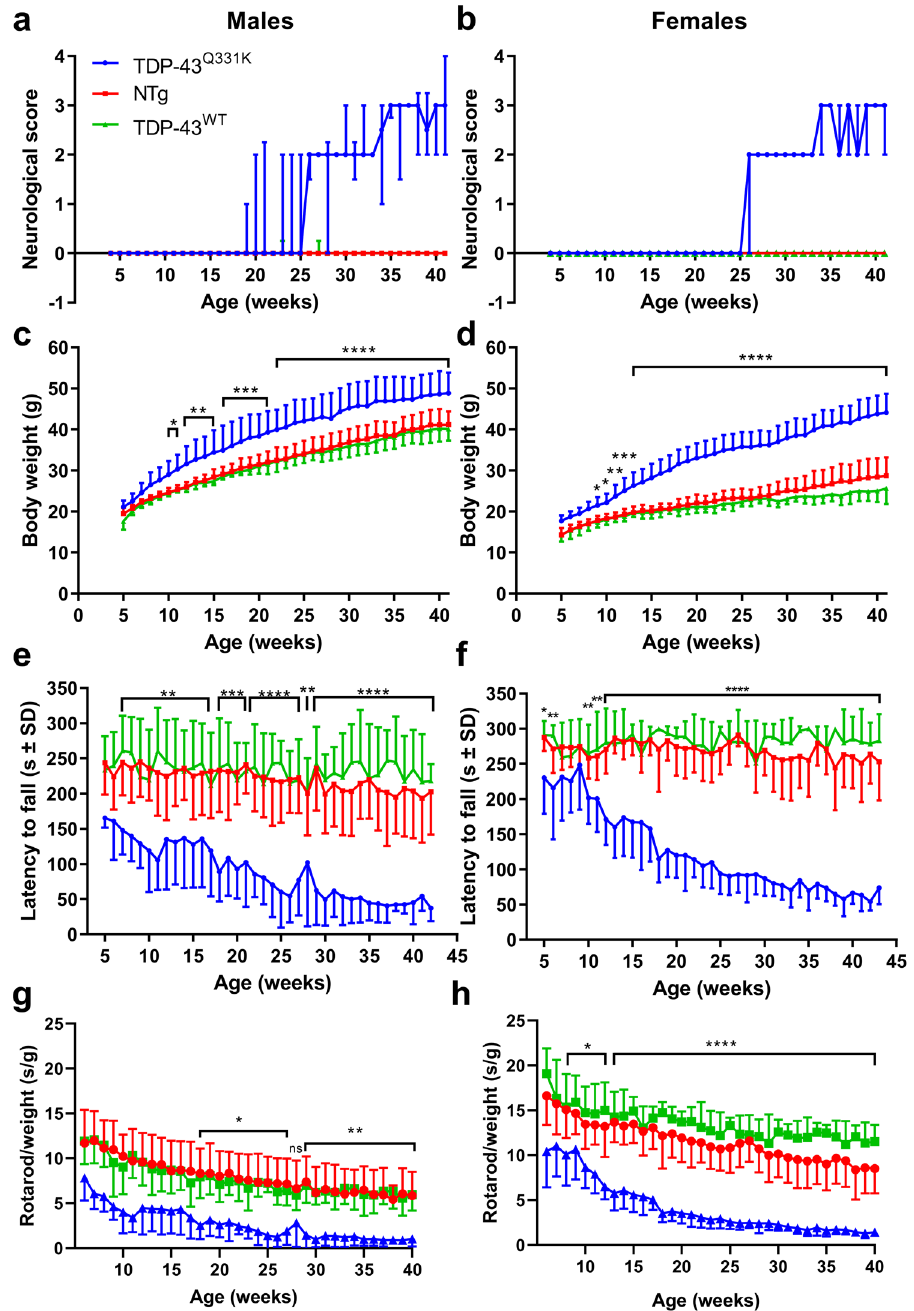
Figure 1. Body weight, CatWalk gait analysis and rotarod performance. ( A ) Male neuroscores. ( B ) Female neuroscores. ( C ) Male body weight. ( D ) Female body weight. ( E ) Male rotarod performance. ( F ) Female rotarod performance. ( G ) Male rotarod performance/weight. ( H ) Female rotarod performance/weight. Error bars represent mean ± SD. All graphs contain data for TDP-43 Q331K (n = 6 per gender—depicted by the blue lines), TDP-43 WT (n = 6 per gender—depicted by the green lines) and non-transgenic (n = 12 per gender—depicted by the red lines) mice compared using a two-way ANOVA with Tukey’s post-tests. * p < 0.05, ** p < 0.01, *** p < 0.001, **** p < 0.0001 TDP-43 Q331K vs all other